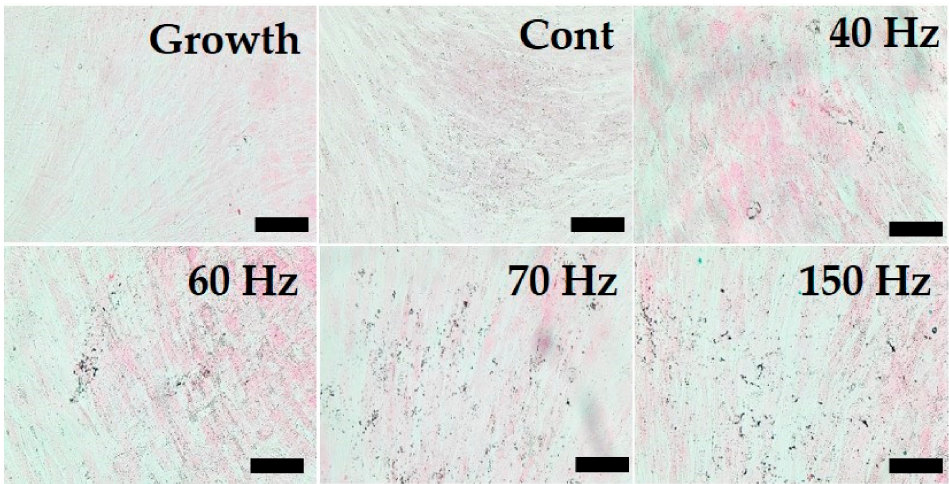
Figure 8. Effects of PEMF exposure on calcium deposition as determined by von Kossa staining at 10 days. Mineral detections were increased in PEMF-stimulated cells. PEMF; pulsed electromagnetic field, hDPSC; human dental pulp stem cell, Cont = control (no PEMF treatment). Growth = growth media (no PEMF treatment). Original magnification: × 200, bar = 100 µ